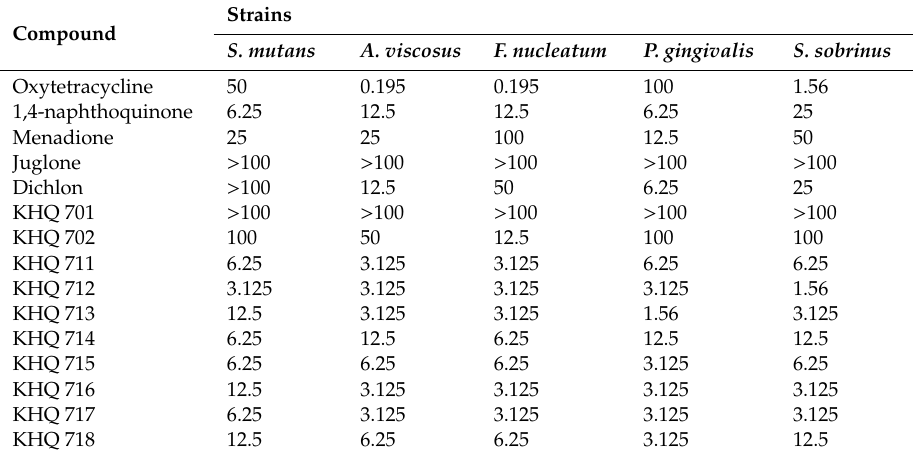
Table 3. Minimum inhibitory concentration (MIC) values ( µ g / mL) against oral